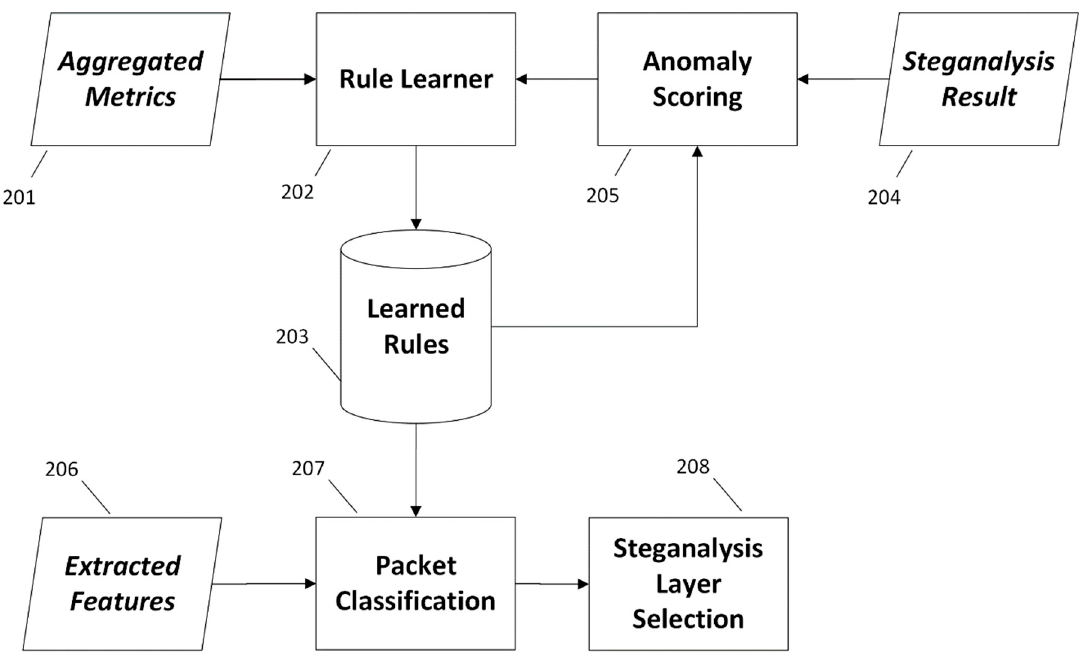
Figure 5. Steganalysis layer selection method .